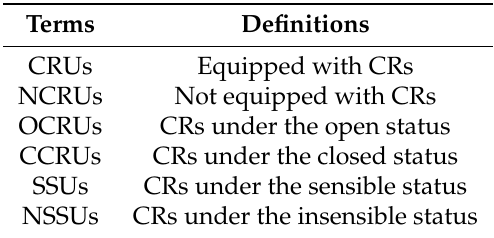
Table 1. Description of different types of SUs.